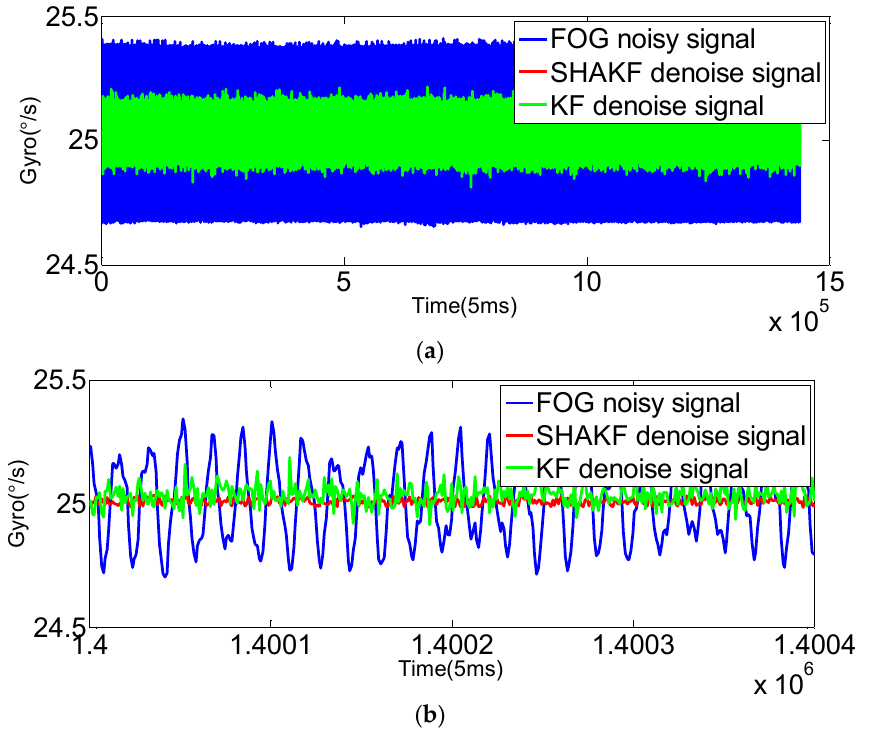
Figure 11. Comparison of the results before and after denoising for the FOG dynamic signal at a rate of 15°/s. ( a ) Denoising the results of the FOG dynamic signal ( x -axis) for 2 h; ( b ) local enlarged graphs.